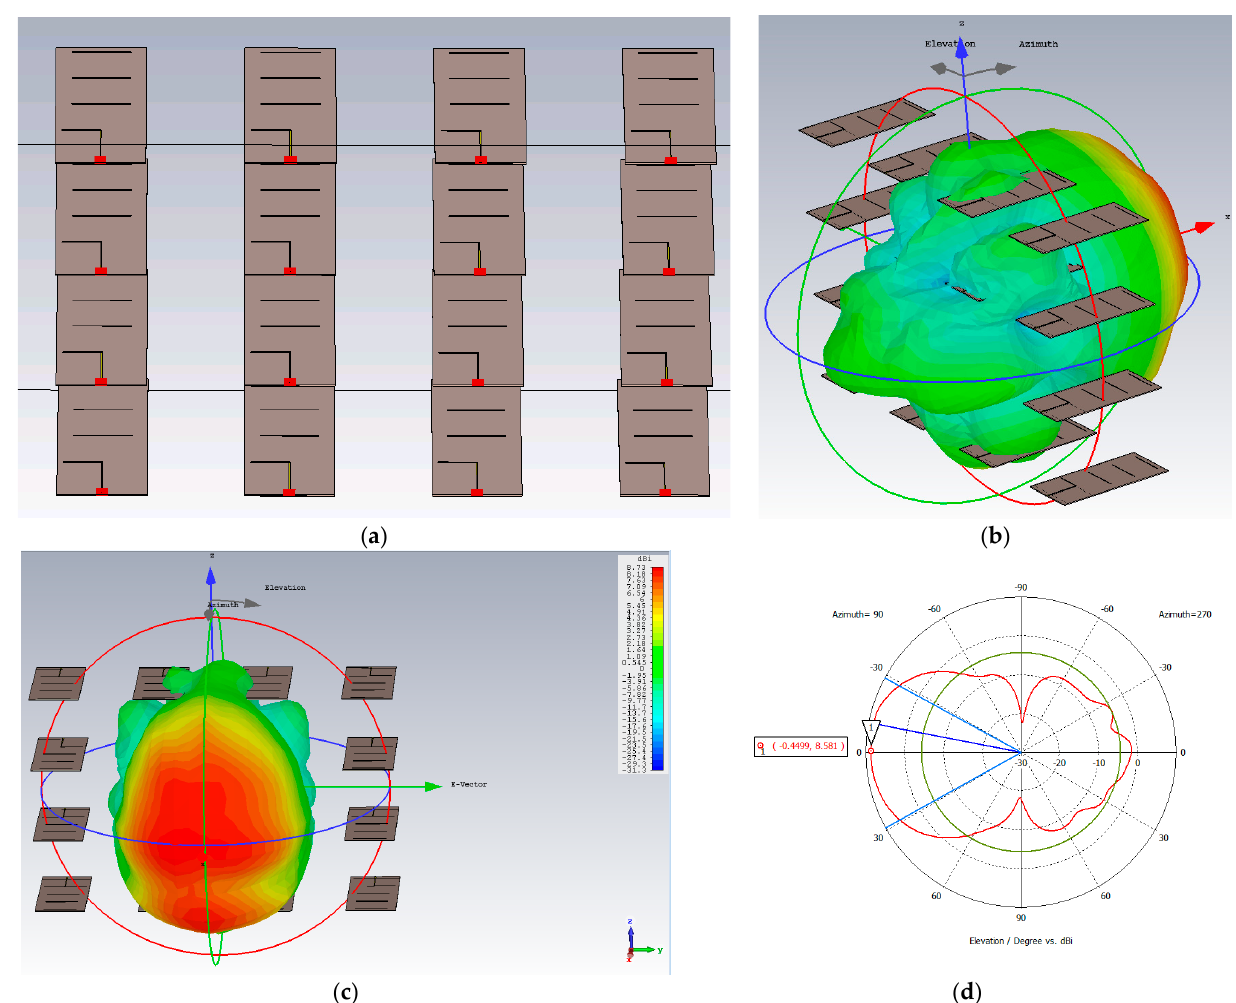
Figure 14. ( a ) Array of 4 × 4 Yagi–Uda elements—Top view; ( b ) Element pattern within an array of 4 × 4 Yagi-Uda elements—Back view; ( c ) Element pattern within an array of 4 × 4 Yagi-Uda elements—Front view; ( d ) Element pattern inside an array of 4 × 4 Yagi-Uda element—Top mesh view .